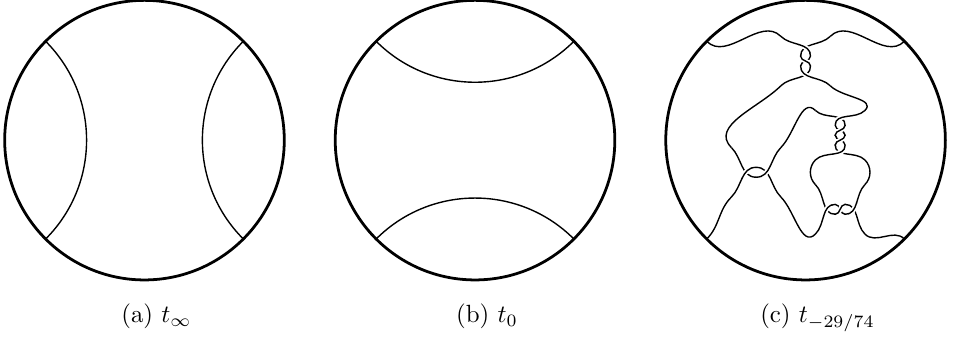
Figure 3. The rational tangles t 1 , t 0 and t continued fraction (cid:0) 1 = (3 (cid:0) 1 = (2 (cid:0) 1 = ( (cid:0) 4 (cid:0) 1 = 3))) = (cid:0) 29